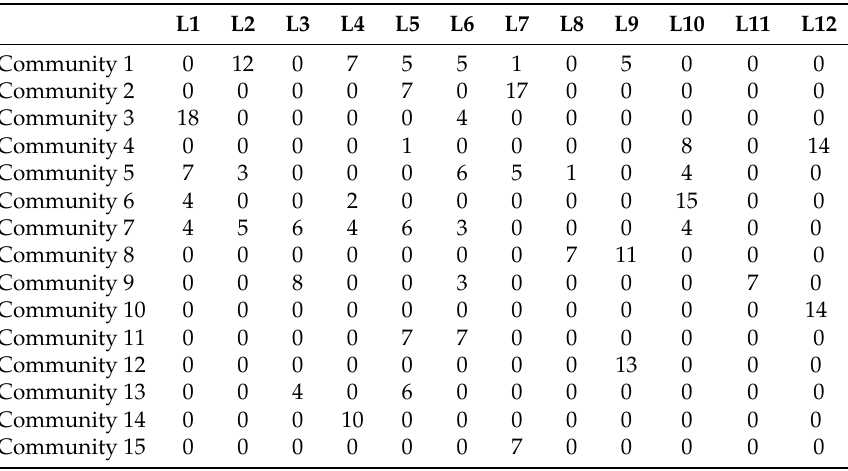
Figure 11. Communities in Madrid metro network. Table 5. Distribution of stations per community and